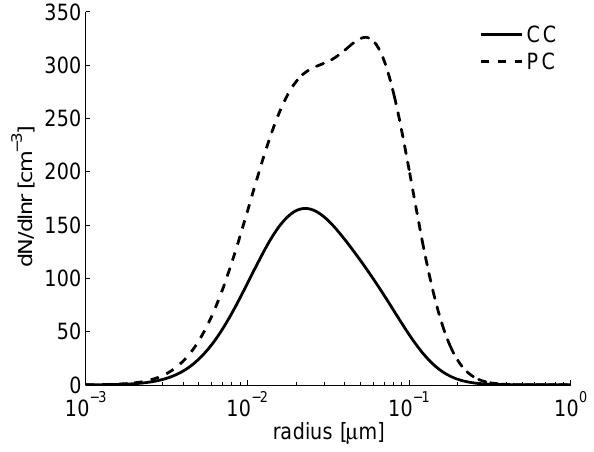
Fig. 2. Aerosol initial conditions for the idealized 2-D simulations. The number density distribution is based on a mean aerosol spec- trum for winter and summer conditions, respectively. The winter aerosol spectrum is taken as the clean case (CC, solid) and the sum- mer aerosol spectrum is taken as the polluted case (PC, dashed).